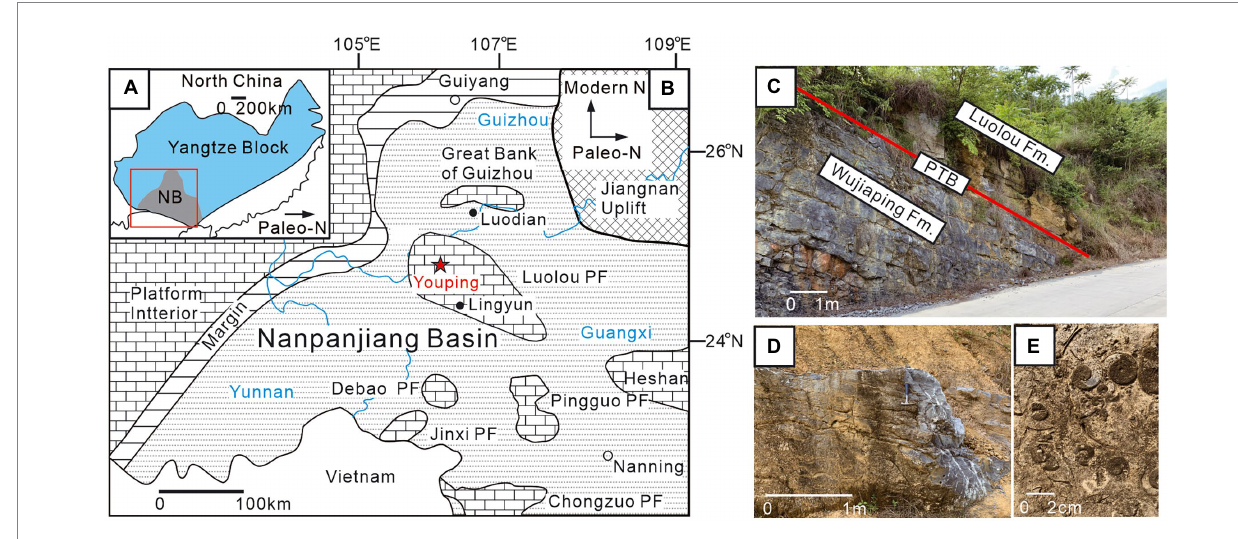
FIGURE 1 Paleogeographic map of the Nanpanjiang Basin and outcrop photos of the Youping section. (A) Paleogeographic map of South China Block (modified after Lehrmann et al., 1998); (B) locality of the Youping section (red star); (C) the Permian–Triassic boundary (PTB, red lined) at the Youping section; (D) microbialites of the basal Louluo Formation; (E) shell bed within the upperpart of microbialites. Fm, Formation; PF,